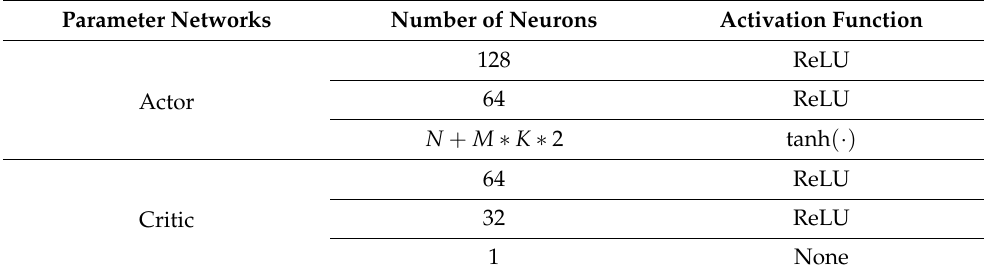
Table 1. Network